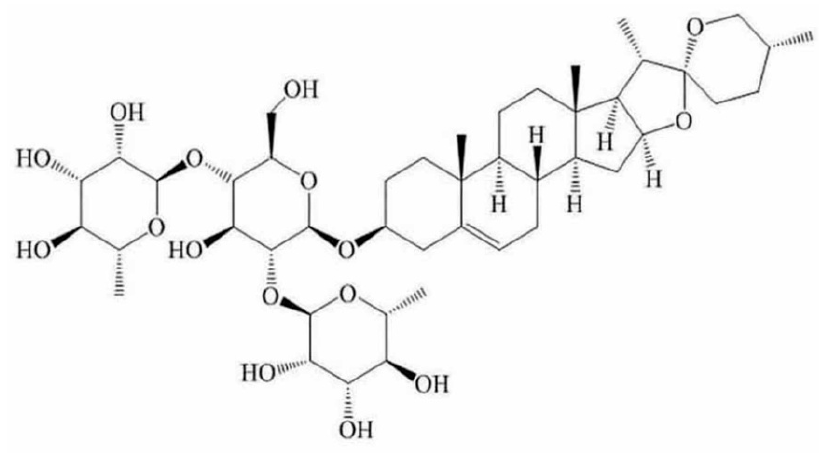
Figure 1. The chemical structure of dioscin.